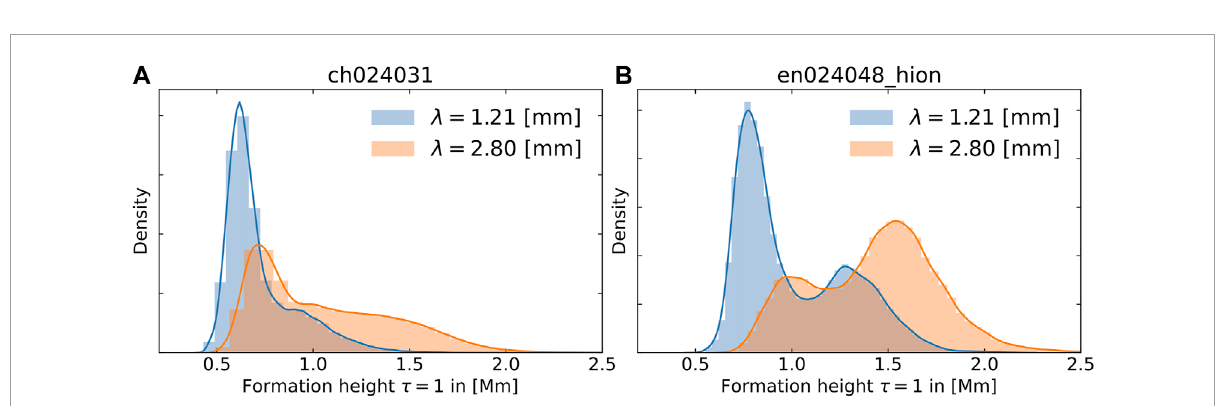
FIGURE 3 Distributions of the heights of optical depth unity [ z ( τ = 1 )] for the two Bifrost models shown in Figure 2 for the continuum at 1.2 mm (blue) and at 2.8 mm (orange): (A) coronal hole and (B) enhanced network region.